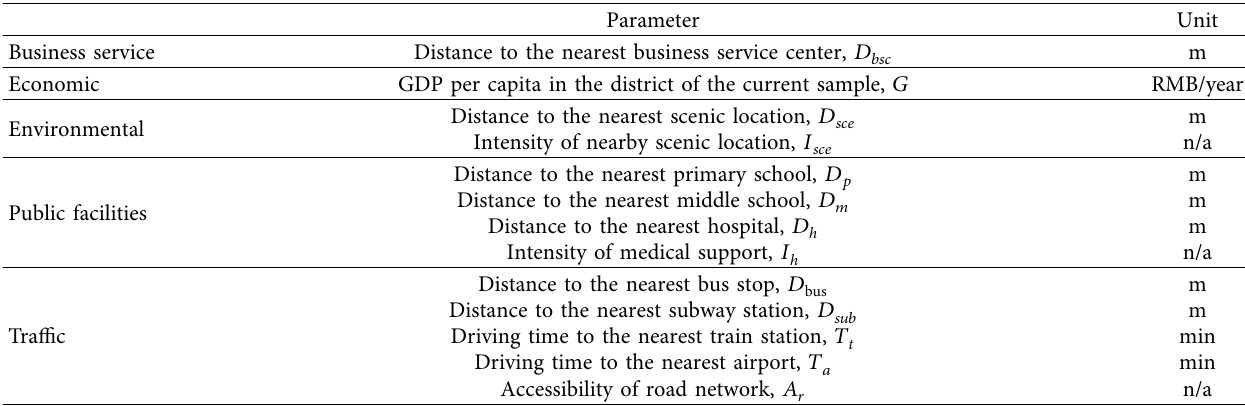
Table 1: Impact factors of residential benchmark land price.